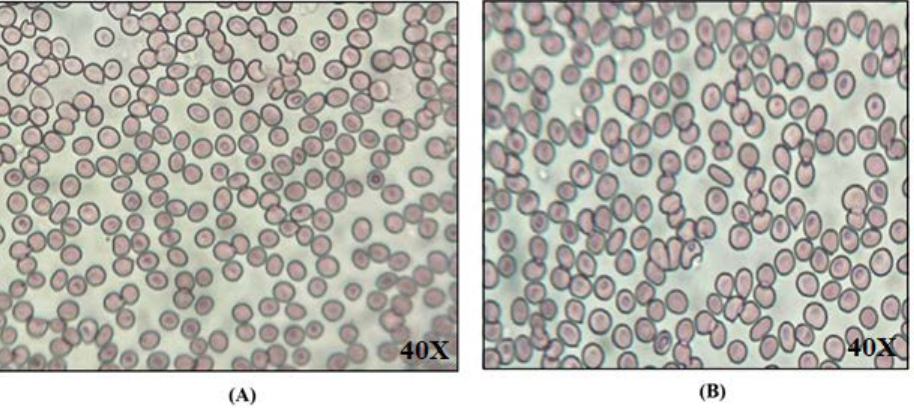
Figure 7. RBCs showing the result of biological compatibility of ( A ) CIP-BLO-opt-IG3 and ( B ) 0.9% w / v NaCl. The study was performed at 40X.